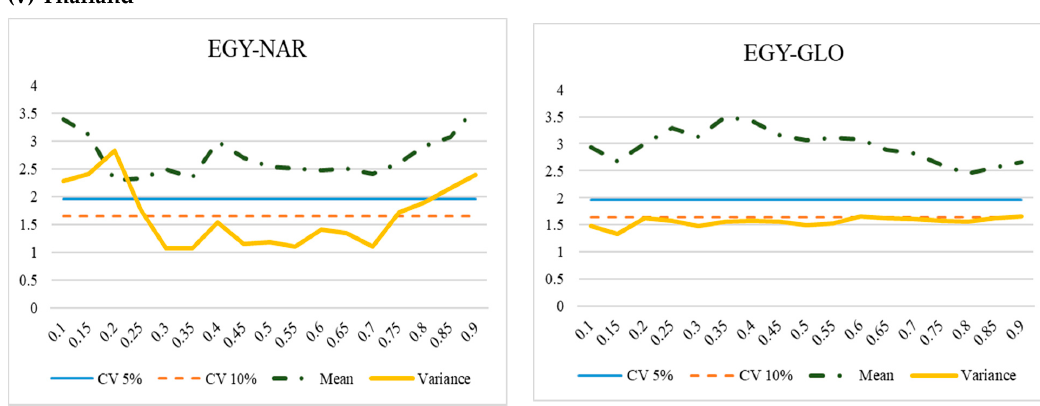
Figure 1. Results from nonparametric causality in quantiles.